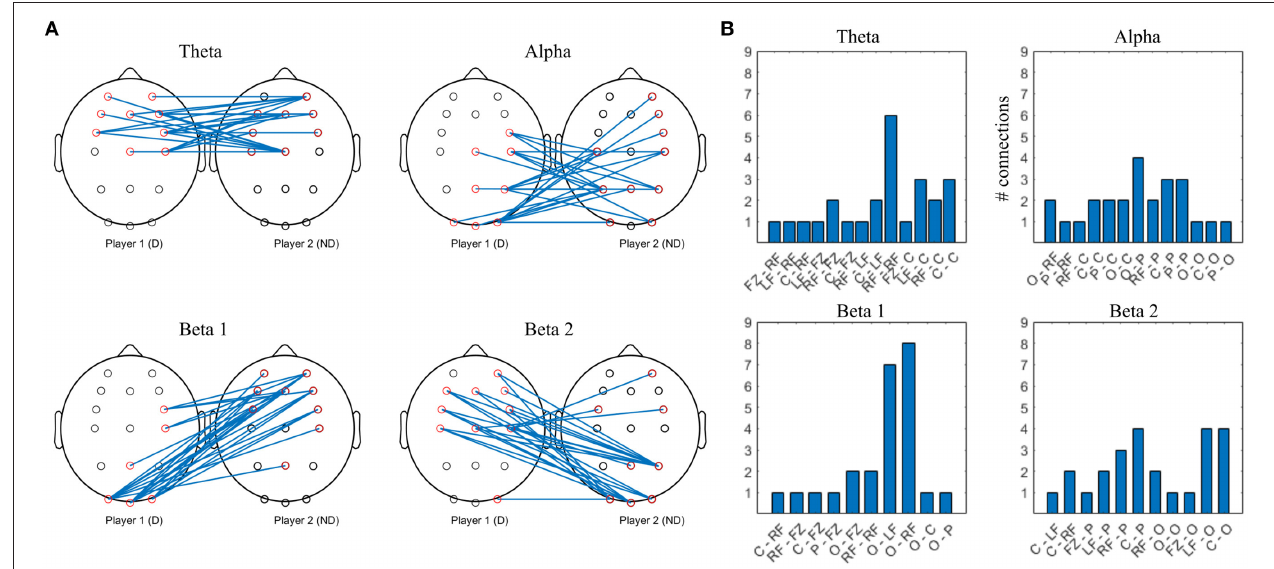
FIGURE 7 | Top 10% strongest connections in collaborative interbrain connectivity; theta = 4–7Hz, alpha = 8–12Hz, beta 1 = 13–20Hz, beta 2 = 21–30Hz. (A) topographical plot. (B) grouped locations. Player 1 (D) first letter; Player 2 (ND) second letter. LF, left frontal; RF, right frontal; C, central; P, parietal; O, occipital.